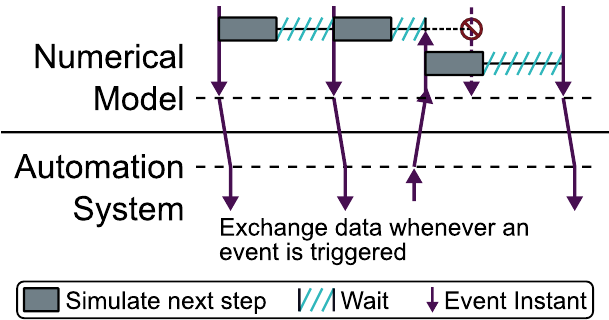
Figure 3. Predictive event mapping: Predicted events will be invalidated and updated as soon as events from the automation system